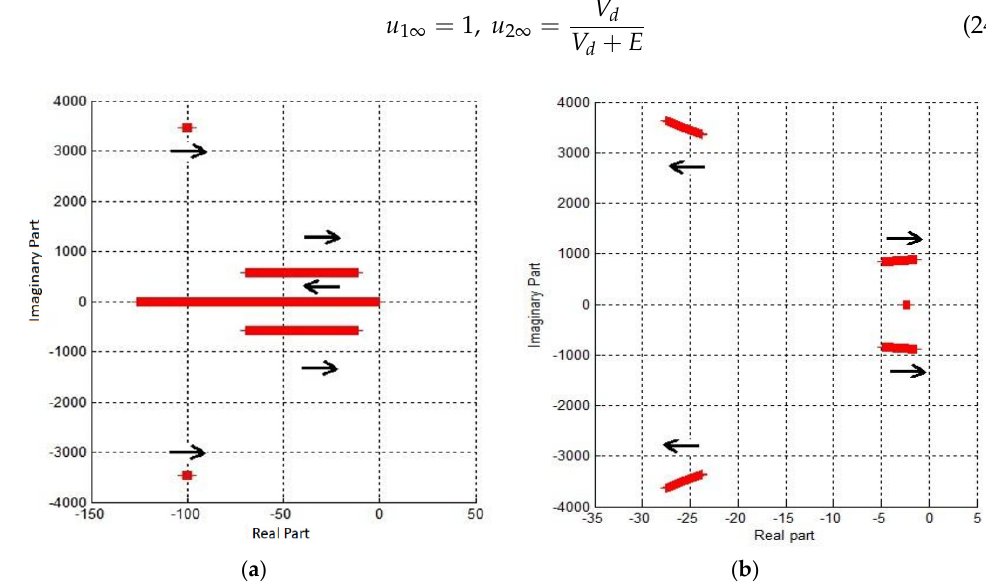
Figure 2. Root locus plot of closed loop characteristics equation. ( a ) Root locus for varying K i when K 1 = 1, K 2 = 1, K P = 0.01, and 0 < K i < 15; ( b ) Root locus for varying K p when K 1 = 1, K 2 = 1, K i = 5 and 0 < K p < 0.2.